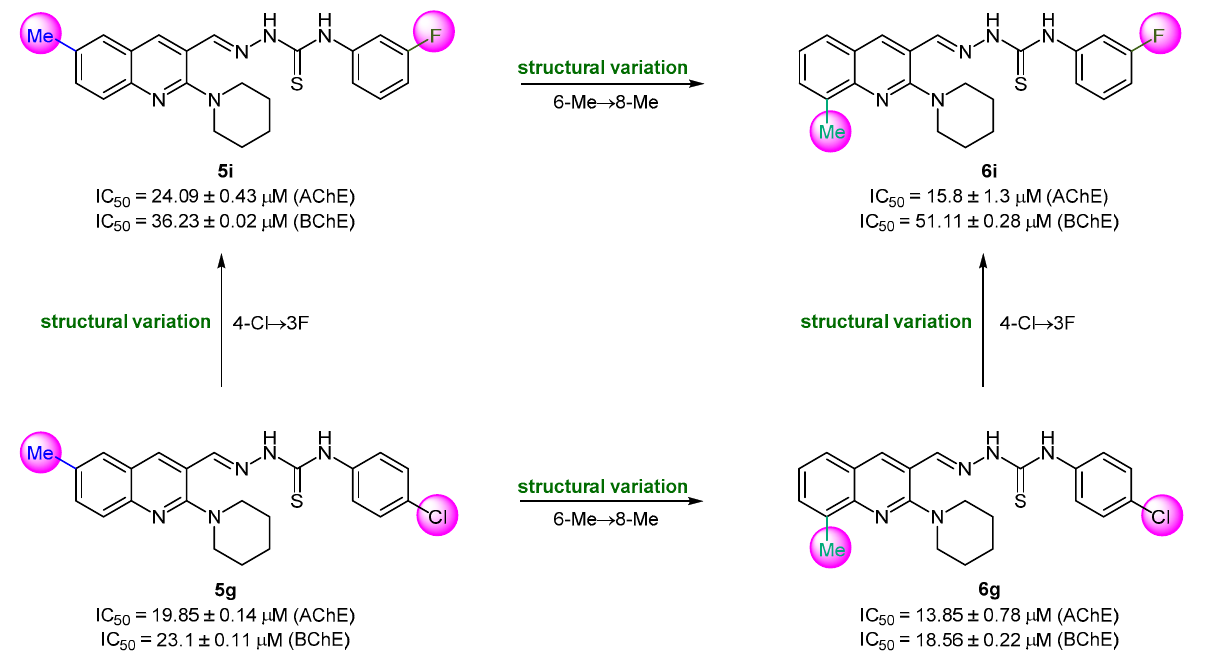
Figure 4. Structure–activity relationship analysis of compounds 5g , 5i , 6g , and 6i .